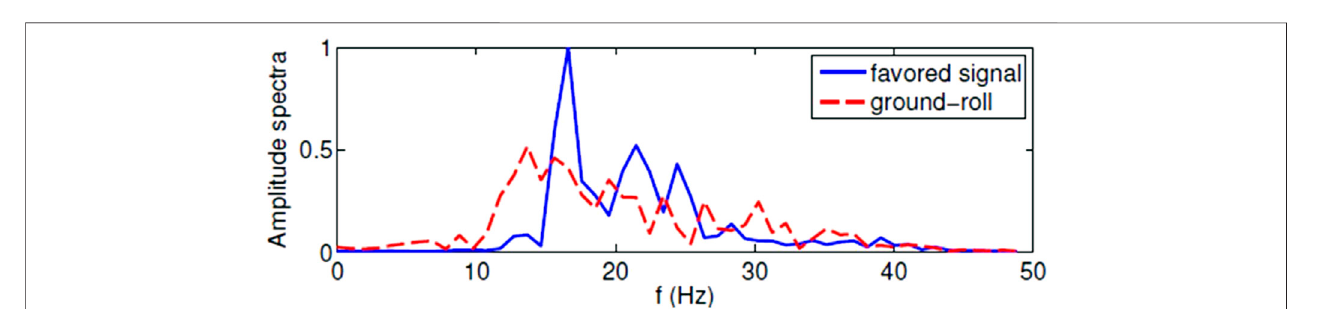
FIGURE 3 | The spectra of the ground-roll noise (red) and the re fl ection signal (blue).